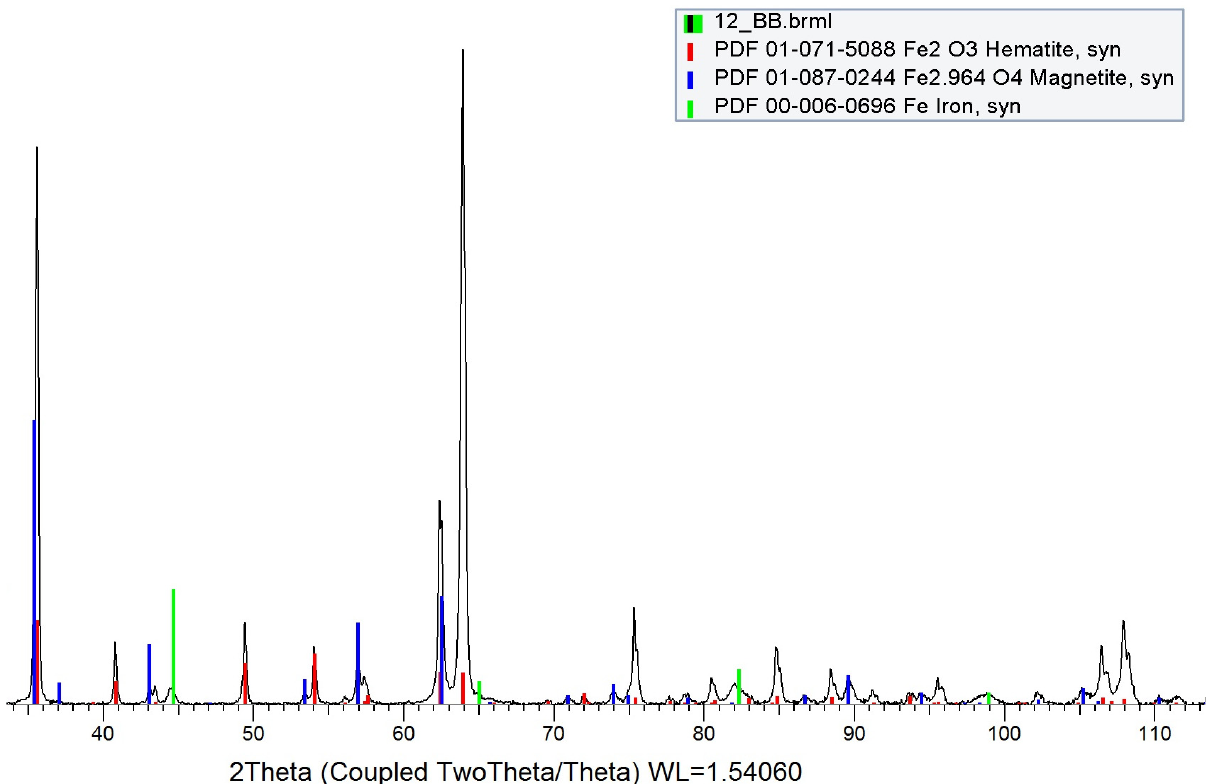
Figure 6. Result of Bragg-Brentano RTG analysis of oxygen layer showing kind of oxigens, sample v9.